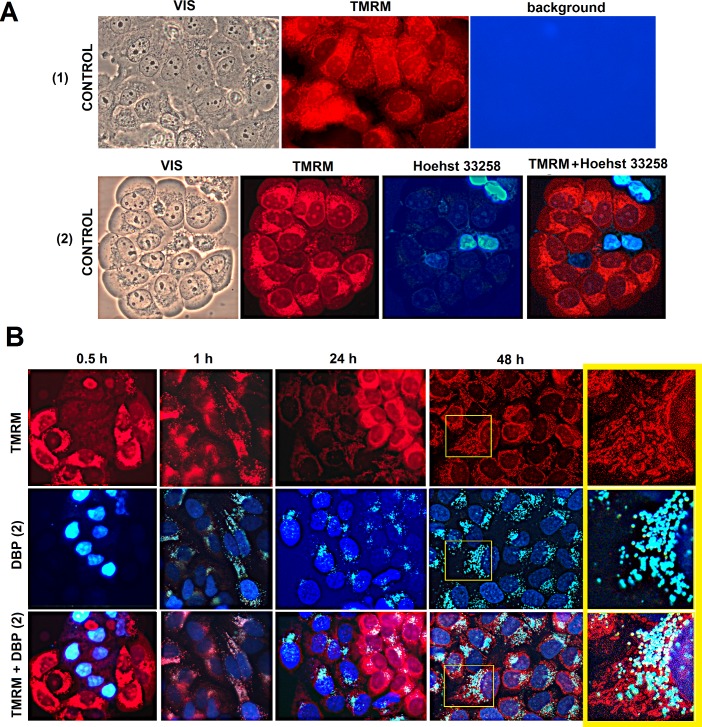
The influence of DBP(1–4) on the MCF-7mitochondria.A. (1)—control cells (stained with MitoTracker TMRM) in visible light (VIS), in λex = 520 nm (TMRM) and in λex = 380 nm (background). (2)—control cells stained with MitoTracker TMRM and Hoechst 33258 (10μM, 0.5 h). Specially selected field shows single cells with a weak mitochondria staining. Particularly these cells accumulate Hoechst 33258 in the nuclei. B. MCF-7 cells treated with 20μM DBP(2) for 0.5–48 h after incubation with MitoTracker TMRM (15 min). For 0.5 h time point we specially selected a field that shows cells with a weak mitochondria staining. DBP(2) quickly penetrates into these cells, similar to Hoechst 33258. Magnification X 60. The cell in a yellow square is enlarged several times for demonstration.